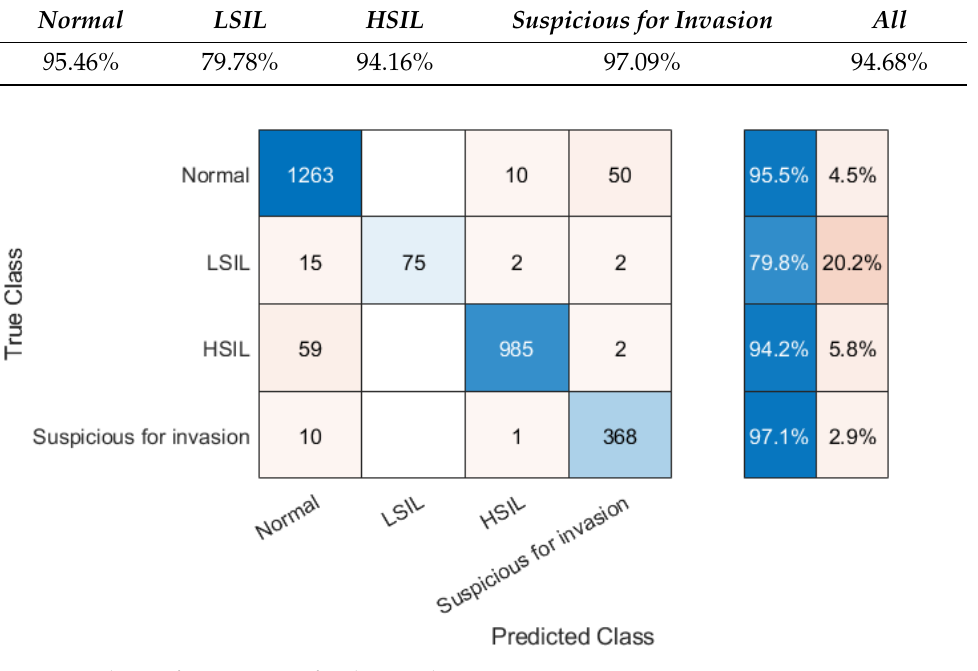
Figure 5. The confusion matrix for the test dataset. Table 3. Comparison of